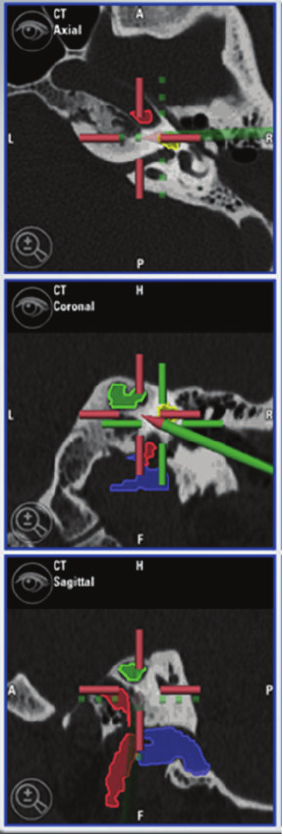
Figure 5: Intraoperative screenshot shows the direction of drilling and the relationship between the surgical route and the surrounding structures ( blue : jugular bulb; yellow : cochlea; red : internal carotid artery; green : petrous apex lesion).